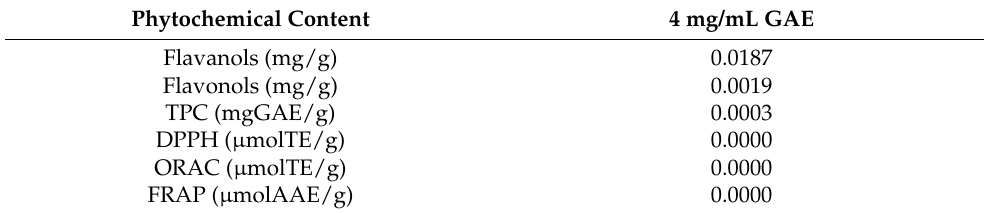
Table 1. Phytochemical analysis and antioxidant capacity of